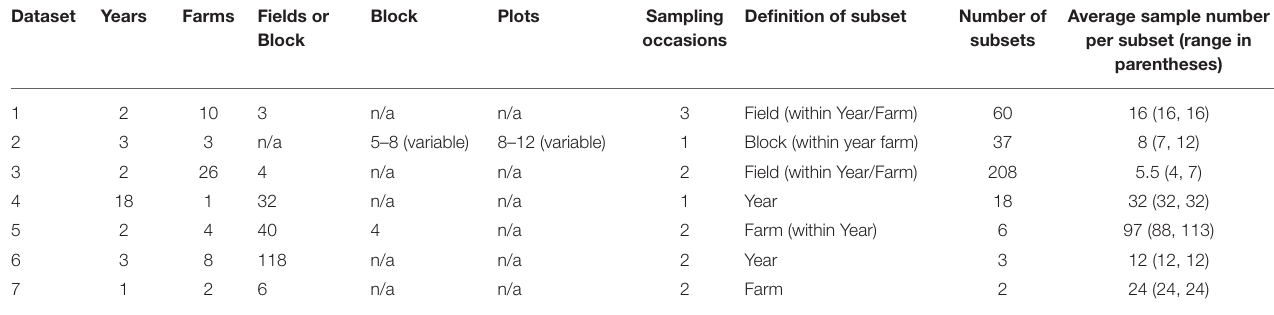
TABLE 2 | Definition and number of subsets in each study.